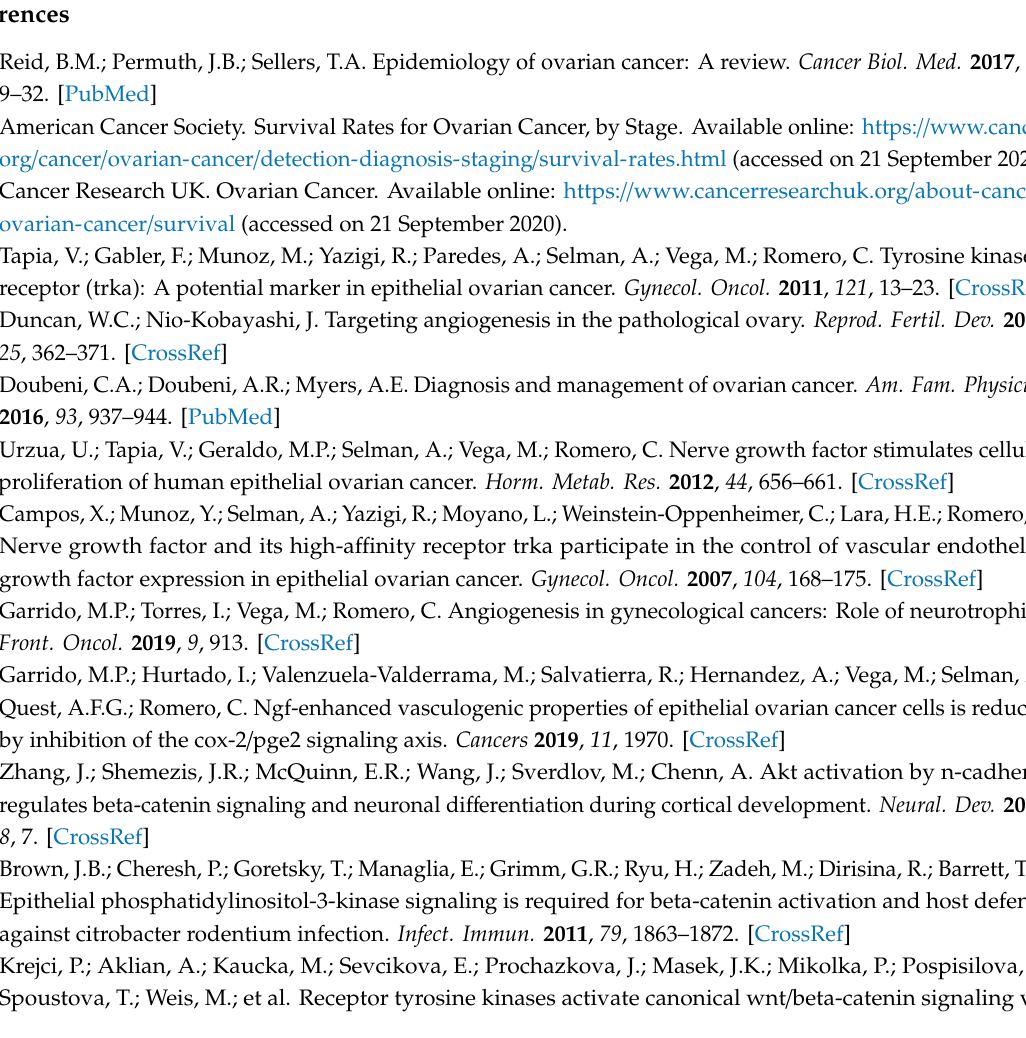
the NGF-induced proliferation of SKOV3 cells, Figure S3: Representative images of c-MYC immunodetection in ovarian cells, Figure S4: NGF activates AKT and ERK signaling pathways in a TRKA dependent manner, Figure S5: Representative images of β -catenin immunodetection in ovarian cells, Figure S6: NGF increases survivin mRNA in ovarian cells, Figure S7: Representative images of survivin immunodetection in ovarian cells, Figure S8: E ff ect of NGF and metformin on the mRNA levels of VEGF in ovarian cells, Figure S9: Metformin prevents the increase in migration and invasion stimulated by NGF in EOC cells, Figure S10: Immunodetection of NGF and Pro-NGF in EOC cells, Figure S11: Metformin prevents ERK activation by NGF in EOC cells, Table S1: Primers sequence using traditional and real time PCR, Table S2: Primers and PCR program employed for miR